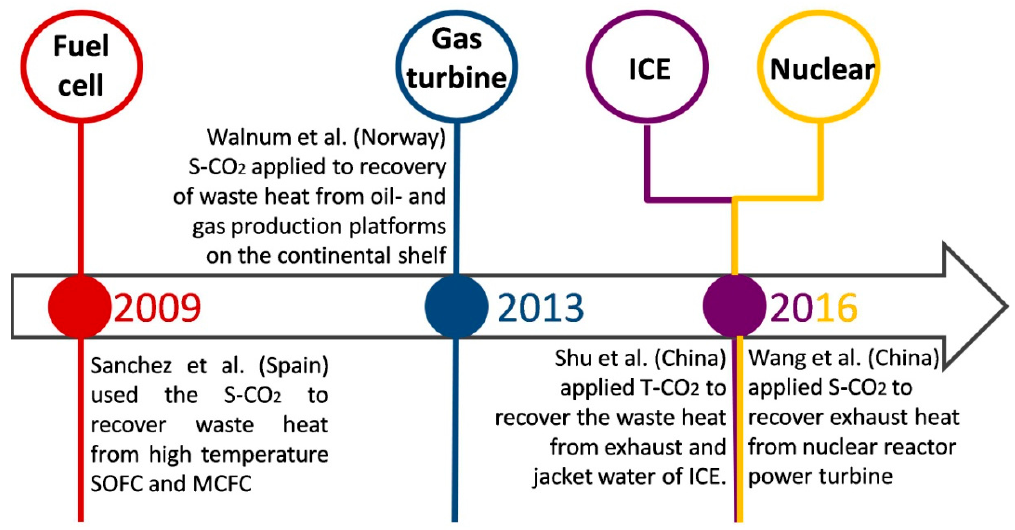
Figure 4. Roadmap of s-CO 2 investigation in different industrial waste heat recovery applications .